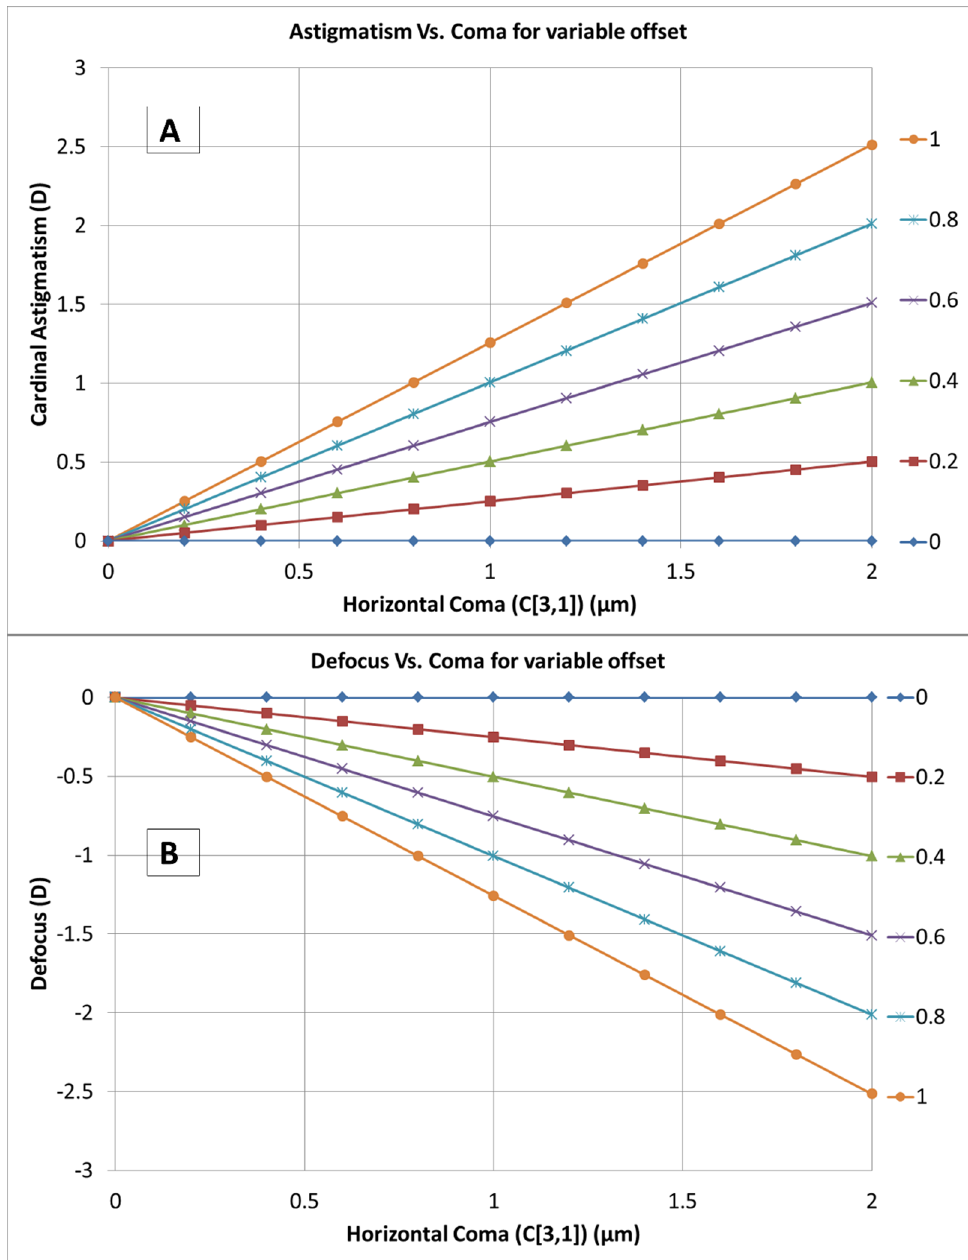
Figure 5. A progression of aberrations with respect to horizontal coma (C[3,1]) for a variable amount of offset (0 to +1 mm). Here, offset represents translation; however, the results are presented with the terminology more popular in the field of refractive surgery. ( A ) Cardinal astigmatism progresses linearly with respect to horizontal coma (C[3,1]) for a variable amount of offset. ( B ) defocus progresses linearly in the negative direction, with respect to horizontal coma (C[3,1]) for a variable amount of offset.